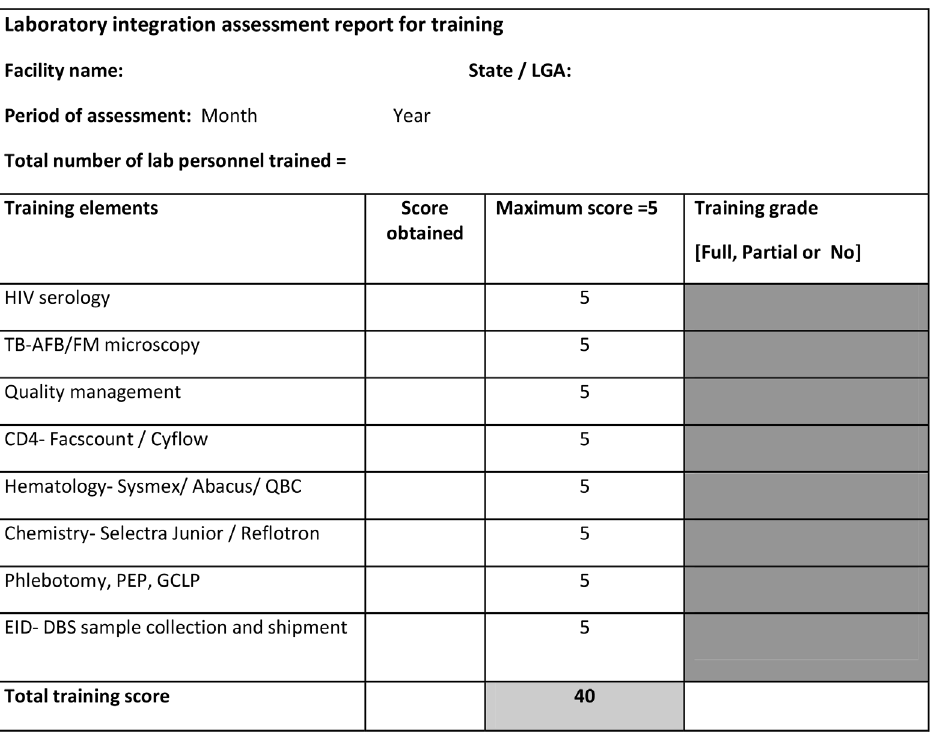
Figure 2. Summary of laboratory integration assessment report format for training. Scoring is based on the % of staff trained in each training element. 5 if $ 80%; 4 if between 60% and 79%; 3 if between 40% and 59%; 2 if between 20% and 39% and 0 if less , 20%. Total Training grade should be filled from the training checklist portion. The total score obtained is added up across all training elements. The percentage score is got from the sum of scores obtained across all training elements expressed as a percentage of the total obtainable score of 40. This information is then captured in the Laboratory integration assessment report (figure 3) in the training row as follows; Rate as FULL (value 2) if $ 80%; Rate as Partial (value 1) if between 25% and 79%; and NO (value 0) if less ,